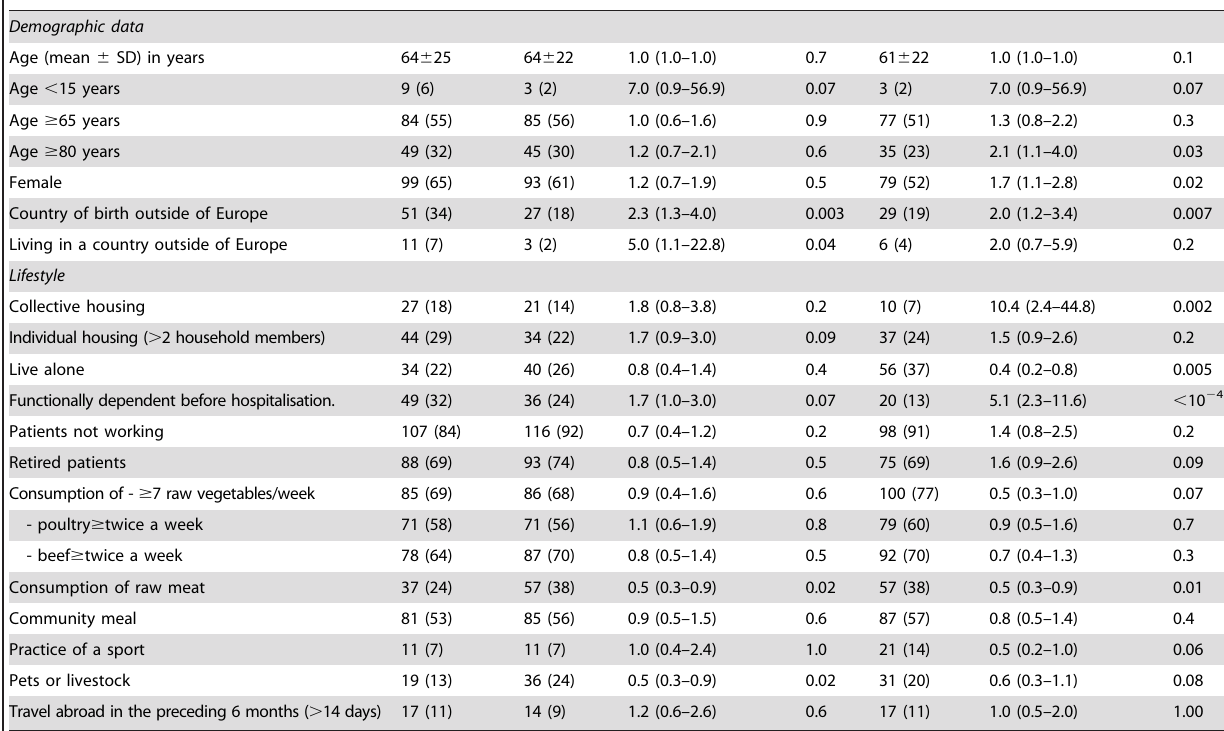
Table 1. Univariate analysis of demographic and lifestyle factors associated with a CTX-M-producing E. coli clinical isolate through a case (patient with a CTX-M producing E. coli isolate) - control (C1: patient with a non-ESBL-producing E. coli isolate) - control (C2: patient with negative clinical samples)